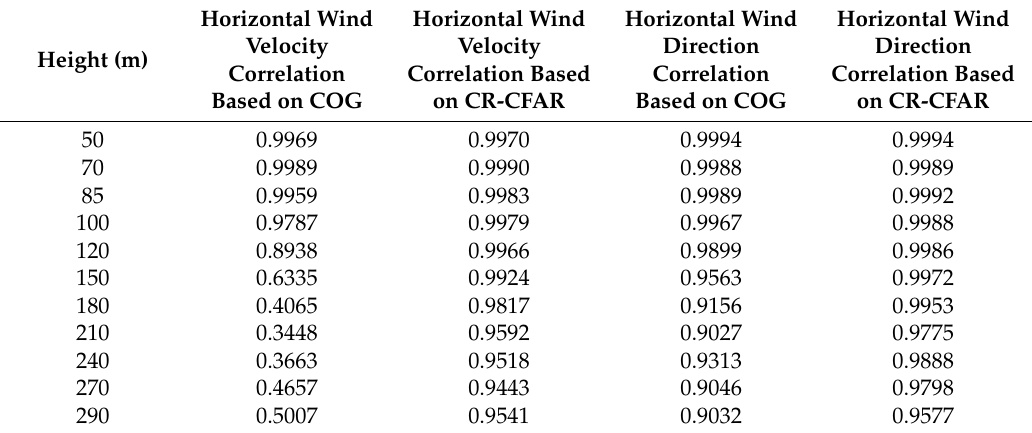
Table 3. Correlations of horizontal wind speed and direction with the commercial lidar at different heights. Horizontal Height (m)